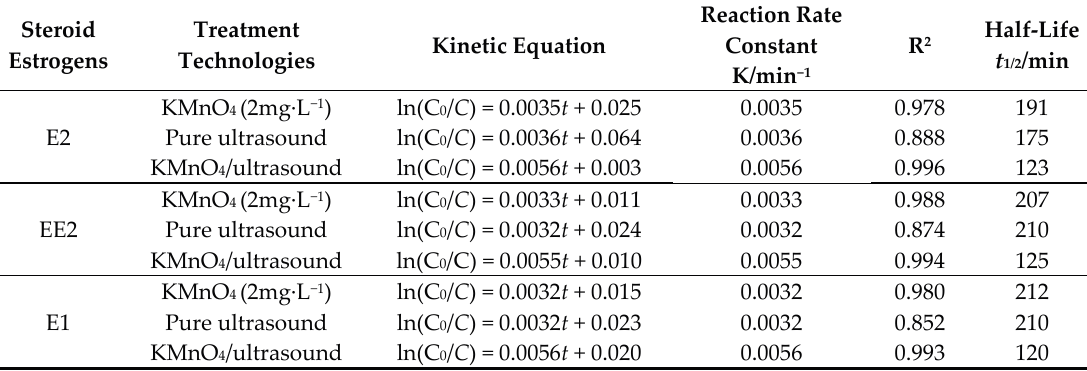
Table 2. Degradation kinetic parameters of SEs under different